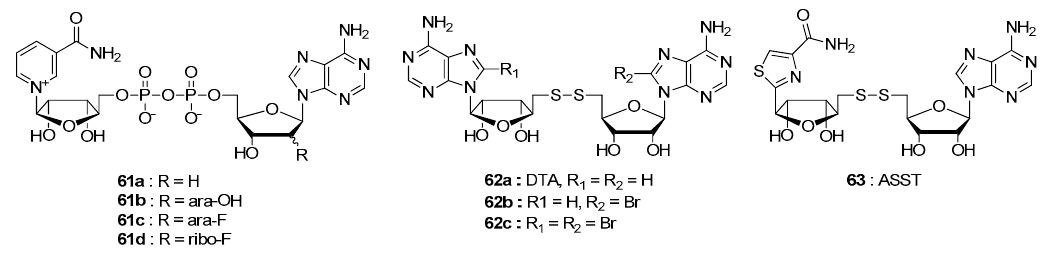
Figure 13. NAD-derived inhibitors of NADK [76].